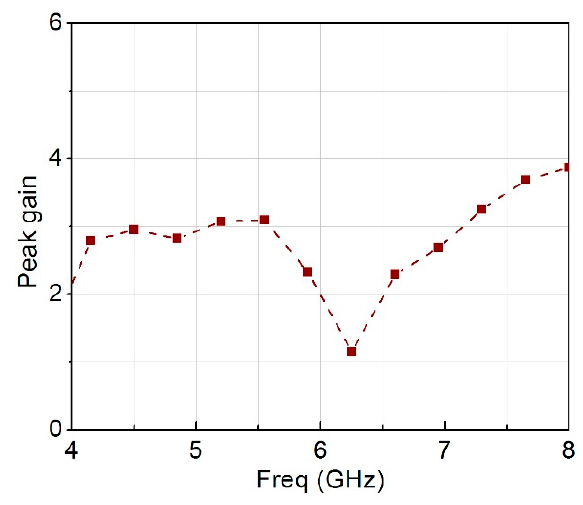
Figure 20. Diversity gain of the MIMO antenna.